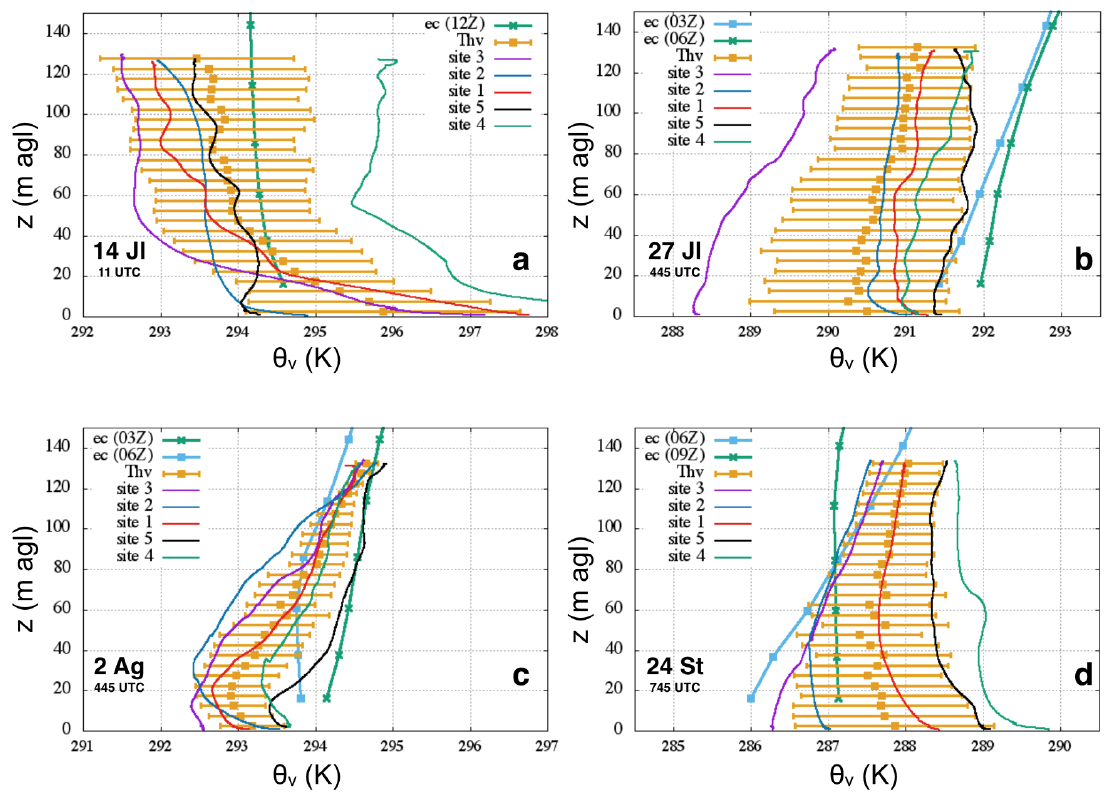
Figure 4. Virtual potential temperature profiles for each experimental case. The thin lines represent individual soundings. Orange profiles correspond to the average profiles and the standard deviation. The thicker blue and green lines with points are the ECMWF outputs for the nearest model grid point and time. ( a ) soundings on 14 July 2017 between 10:17 and 11:51 UTC; ( b ) 27 July between 3:44 and 5:31 UTC; ( c ) 2 August between 4:02 and 5:25 UTC; ( d ) 24 September between 7:10 and 8:15 UTC.